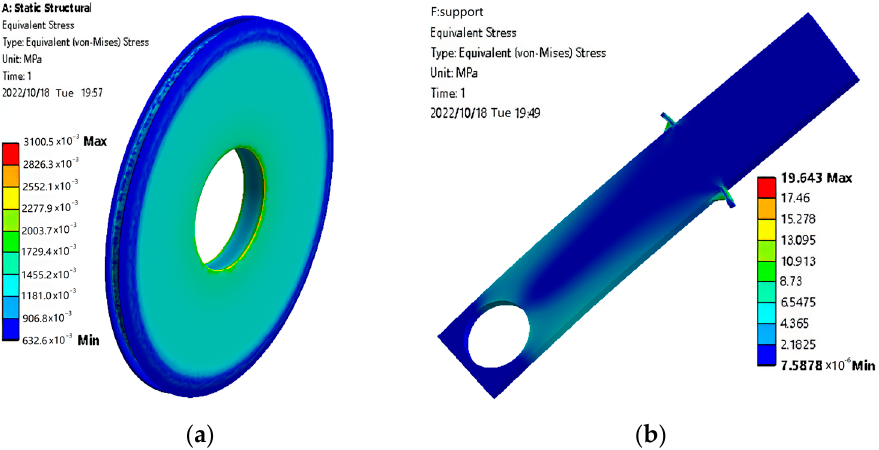
Figure 17. Stress cloud diagram of topological targets. ( a ) Rope wheels; ( b ) counterweight support.